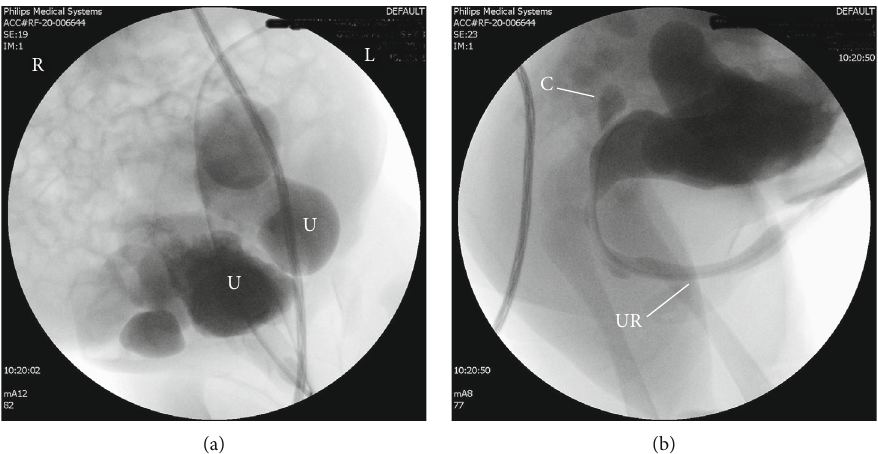
Figure 4: (a) Voiding cystourethrogram showed grade 5 left vesicoureteral re fl ux (ureter (U)). (b) Dilatation of the posterior and anterior urethra and cystic structure posterior to the urinary bladder (utricle cyst) (cyst (C), urethra (UR)).